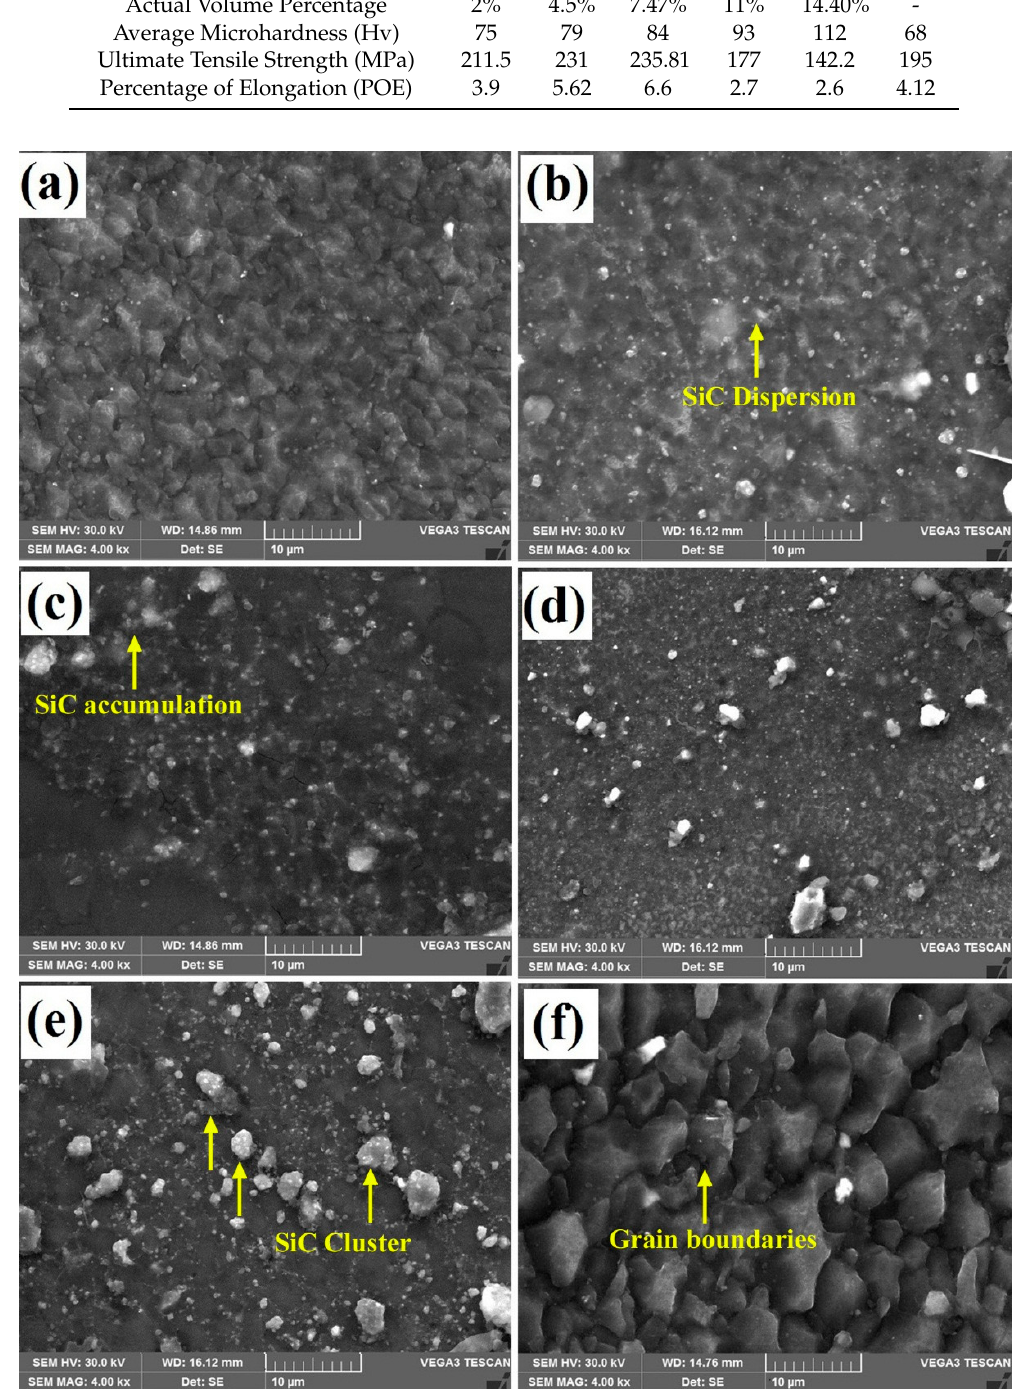
Figure 10. SEM micrograph of the AZ31B/SiC composite joints with fine distribution. ( a ) V4; ( b ) V8; ( c ) V12; ( d ) V16; ( e ) V20; ( f ) V0-FS welded without SiC.